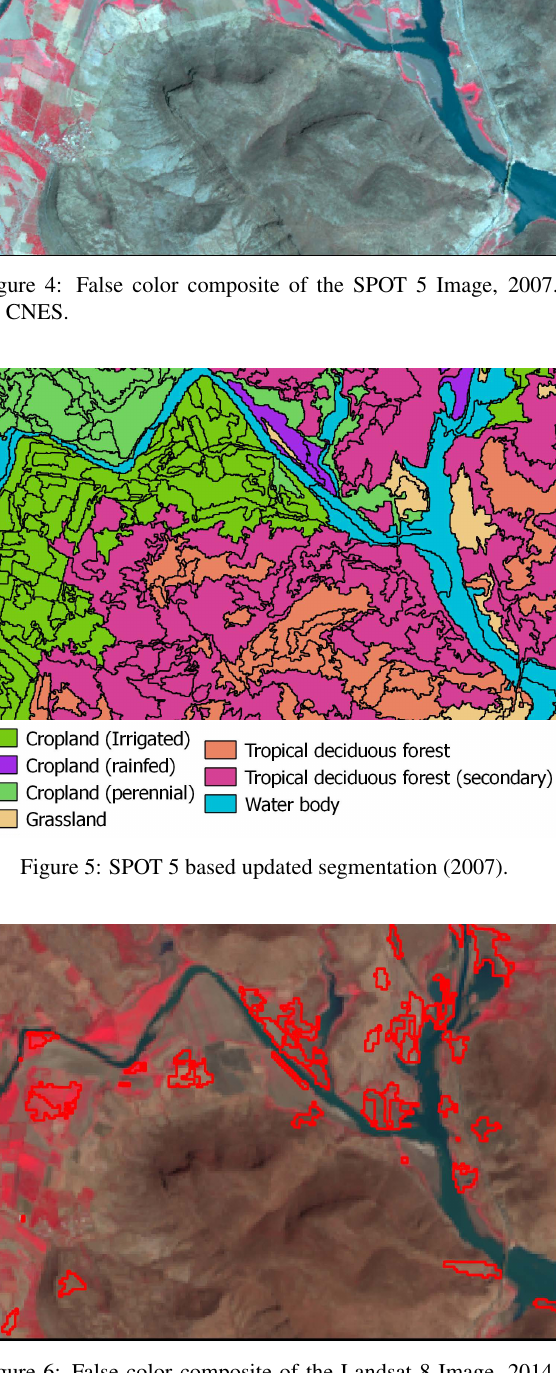
Figure 6: False color composite of the Landsat 8 Image, 2014. c (cid:13) USGS/NASA Landsat. Red objects were the “uncertain” seg-